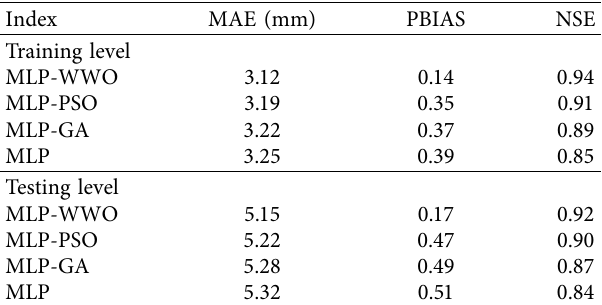
Table 4: Training level for the statistical results related to soft computing models based on the daily scale.